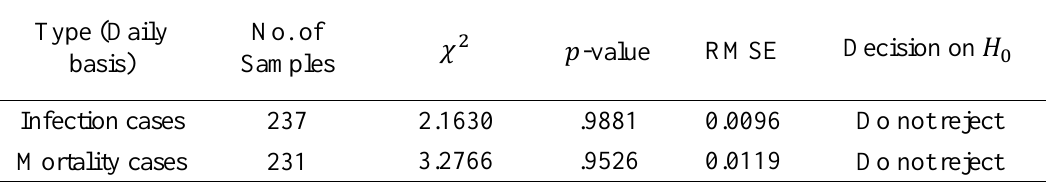
Table 2. Statistics of Indonesia daily infection and death cases for NBL of the second